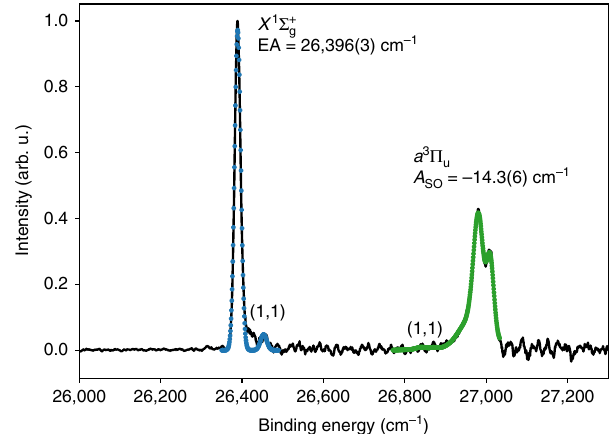
Fig. 3 Velocity-map image of C (cid:1) the detector edge with slow electrons at the centre, whereas the laser polarisation de fi nes the vertical axis. Two transitions are observed, with detachment to the ground X 1 Σ þ detachment to the fi rst excited a 3 Π The two transitions display opposite anisotropies, with the 1 Σ þ preferentially distributed at the poles of the image and the a 3 Π weakly focused around the horizontal axis